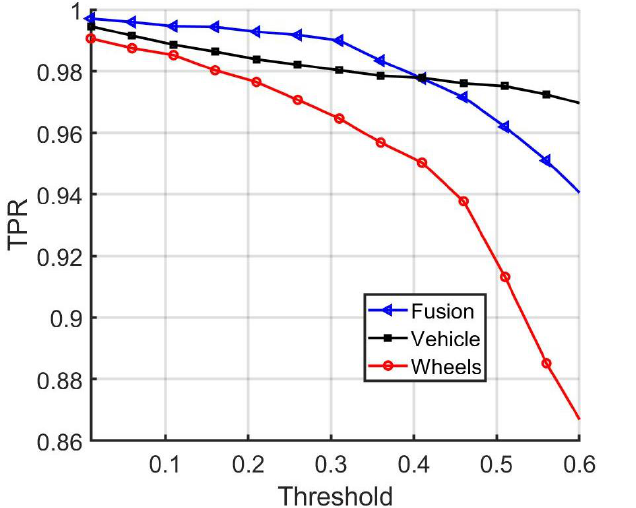
Figure 12. Comparison of the baseline, vehicle, and wheel-network-matching true positive rates.